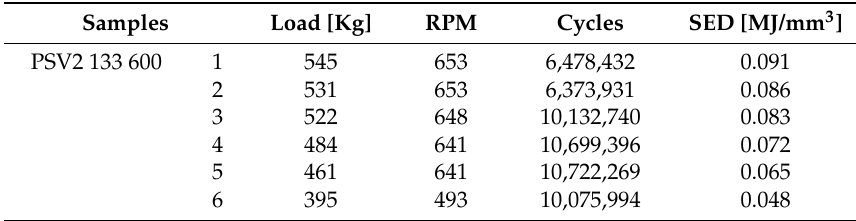
Table 3. Fatigue data for the roller PSV2 133 600.